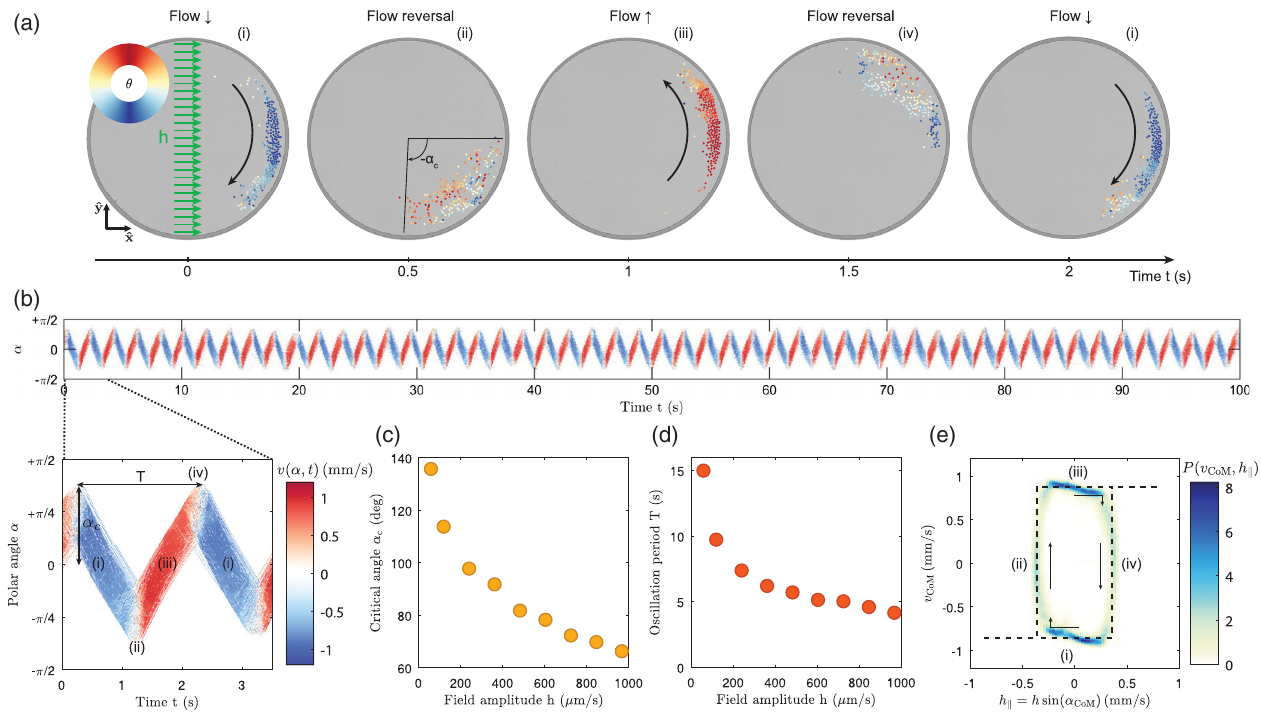
FIG. 5. Spontaneous oscillations of a polar-liquid droplet. (a) Subsequent pictures of a polar liquid droplet oscillating spontaneously in a circular chamber of radius R ¼ 0 . 5 mm. The green arrows indicate the direction of h . The color of the particles indicates the instantaneous direction of their velocity θ . The polar-liquid droplet reverses its motion when it reaches a critical angle (cid:2) α along the c curved boundary. h ¼ 485 μ m = s. (b) Time variations of the radial average of the active-liquid flow v ð α ; t Þ , showing a well-defined period T and amplitude α of oscillations. The four states defined in (a) are indicated in the close-up view. (c) The critical angle α c is c reduced when increasing the magnitude of the external field h . R ¼ 2 . 3 mm. (d) The period of the oscillations T is reduced when ; h Þ . The support of this probability is increasing the magnitude of the external field h . R ¼ 2 . 3 mm. (e) Density of probability P ð v k CoM defined by the hysteresis cycle. The dashed line shows a sketch of the dynamical response of the polar liquid, and the arrows give the direction of the cycle exploration. The four states defined in (a) correspond to the four branches of the hysteresis